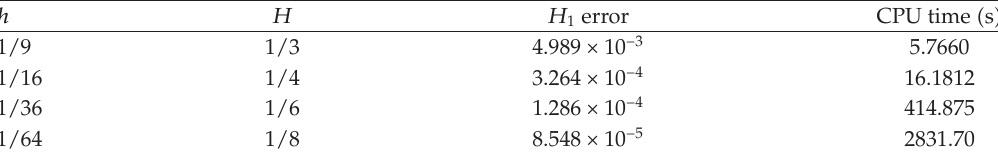
Table 2: H 1 error and CPU time of the two-grid finite element